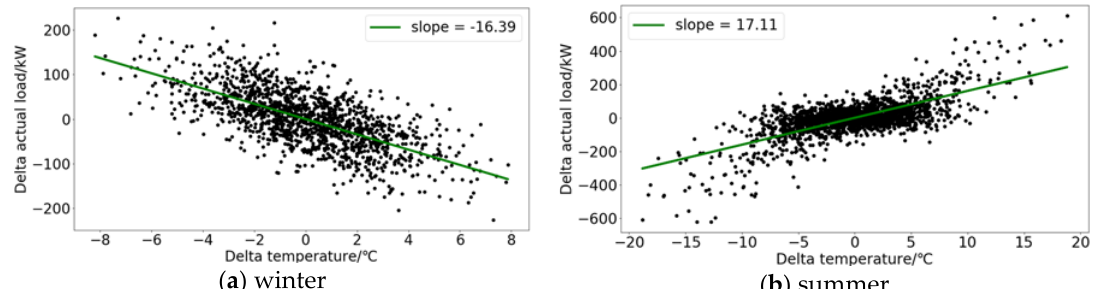
Figure 2. An example of the relationship between delta temperature and delta actual load at 17:00 in winter and summer.